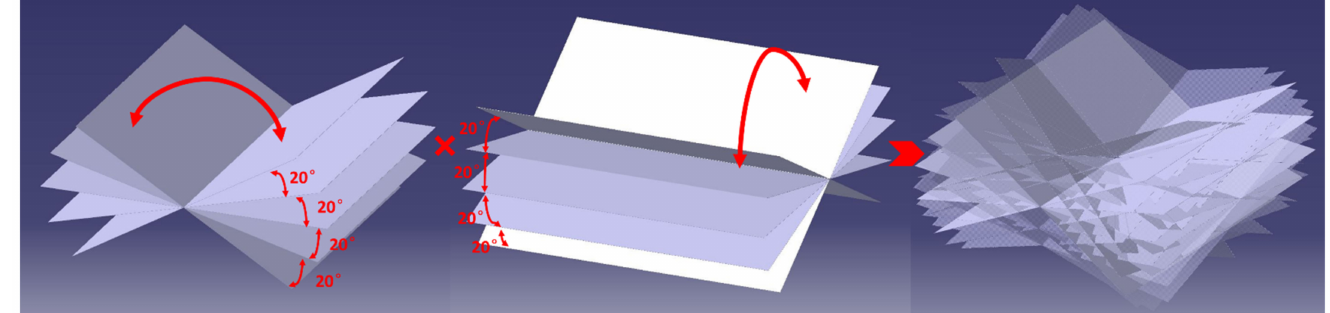
Figure 7. The schematic of ArUco pose in each sampling area.